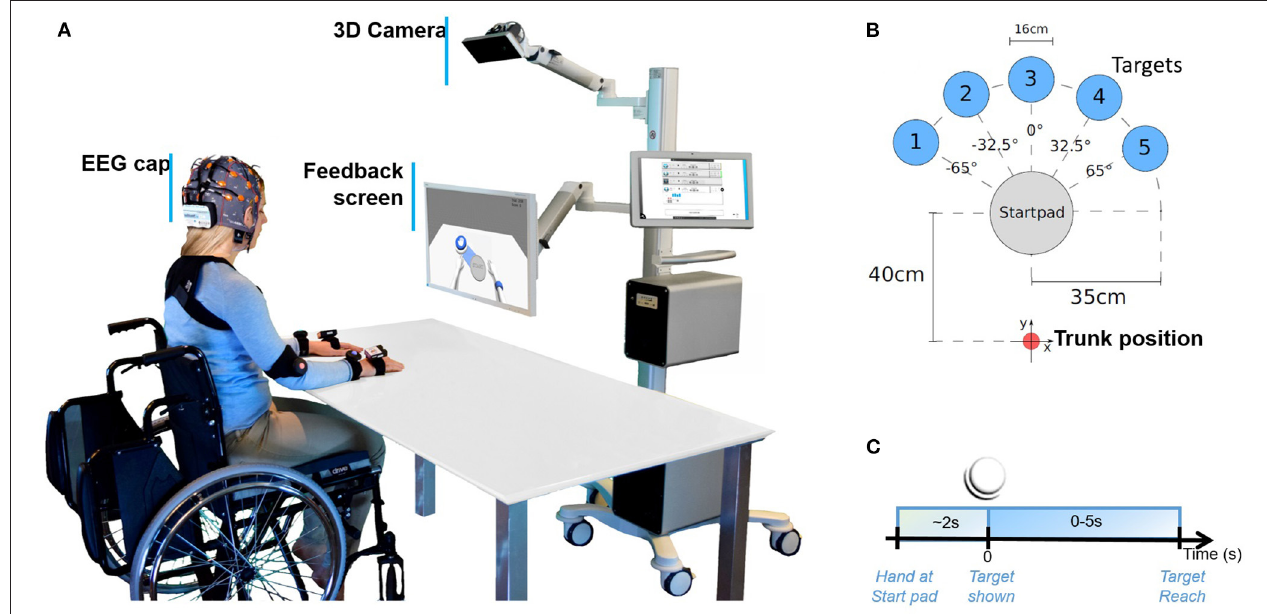
FIGURE 1 | Illustration of the experimental setup. (A) A participant performing centered-out movements over the 2D surface of a table in front of the MindMotion TM PRO virtual reality platform. A 3D camera tracks the participant’s movements and projects them onto a feedback screen. (B) Approximate locations of the five virtual targets are illustrated with respect to the participant’s trunk position. (C) Timeline of events of each repetition of the center-out reaching task.